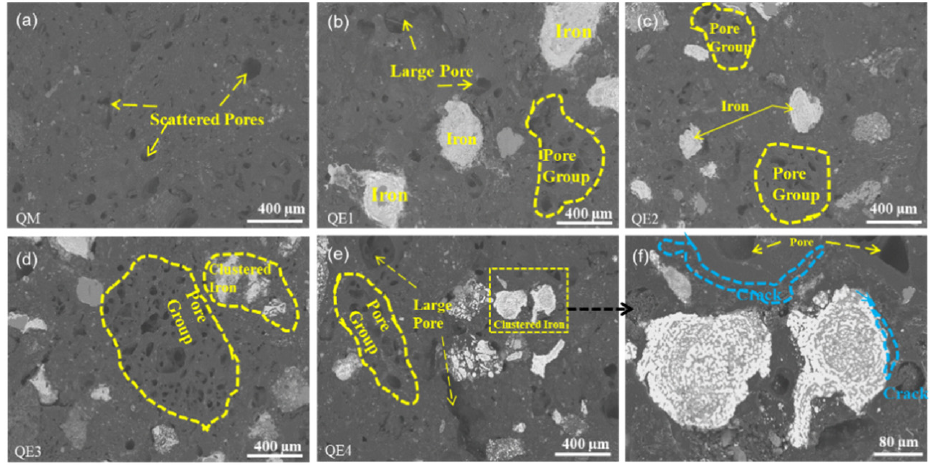
Figure 8. SEM of ferro-coke with different amounts of iron ore: ( a ) 100%QM; ( b )90%QM + 10%EX; ( c ) 80%QM + 20%EX; ( d ) 70%QM + 30%EX; ( e ) 60%QM + 40%EX, and ( f ) 60%QM + 40%EX.